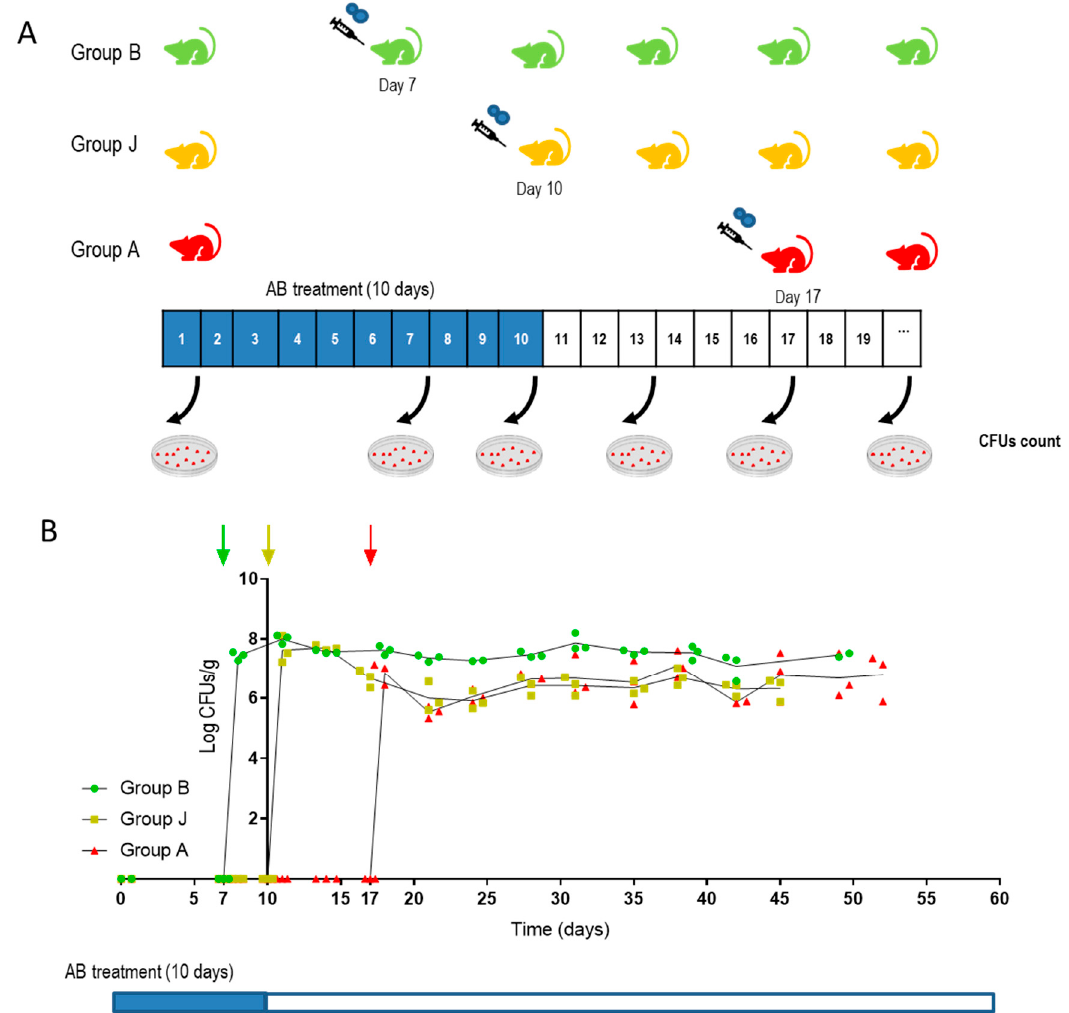
Figure 5. Determination of the minimum antibiotic regimen to allow gut colonization ( A ) Schematic representation of the assay, three groups of mice were treated with antibiotics for 10 days, 10 7 CaORAL3 cells were inoculated 3 days before ( B ), just after (J) or 7 days after ( A ) the 10-days antibiotic treatment. Stool samples were taken at different time and processed for CFUs count. Data are shown as Log CFU/g of feces ( B ). Arrows indicate C. albicans inoculation for each group.